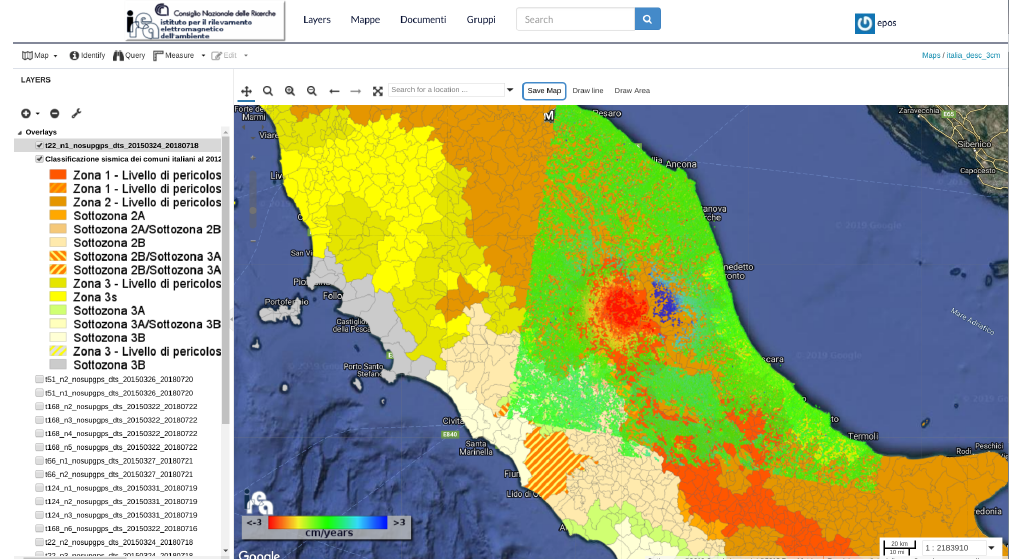
Figure 19. Example of joint analysis of different data sources: overlap of the DInSAR mean deformation velocity (see Figure 10) and the Italian municipalities seismic classification [118] maps relevant to the zone affected by the 2016-2017 seismic crisis in central